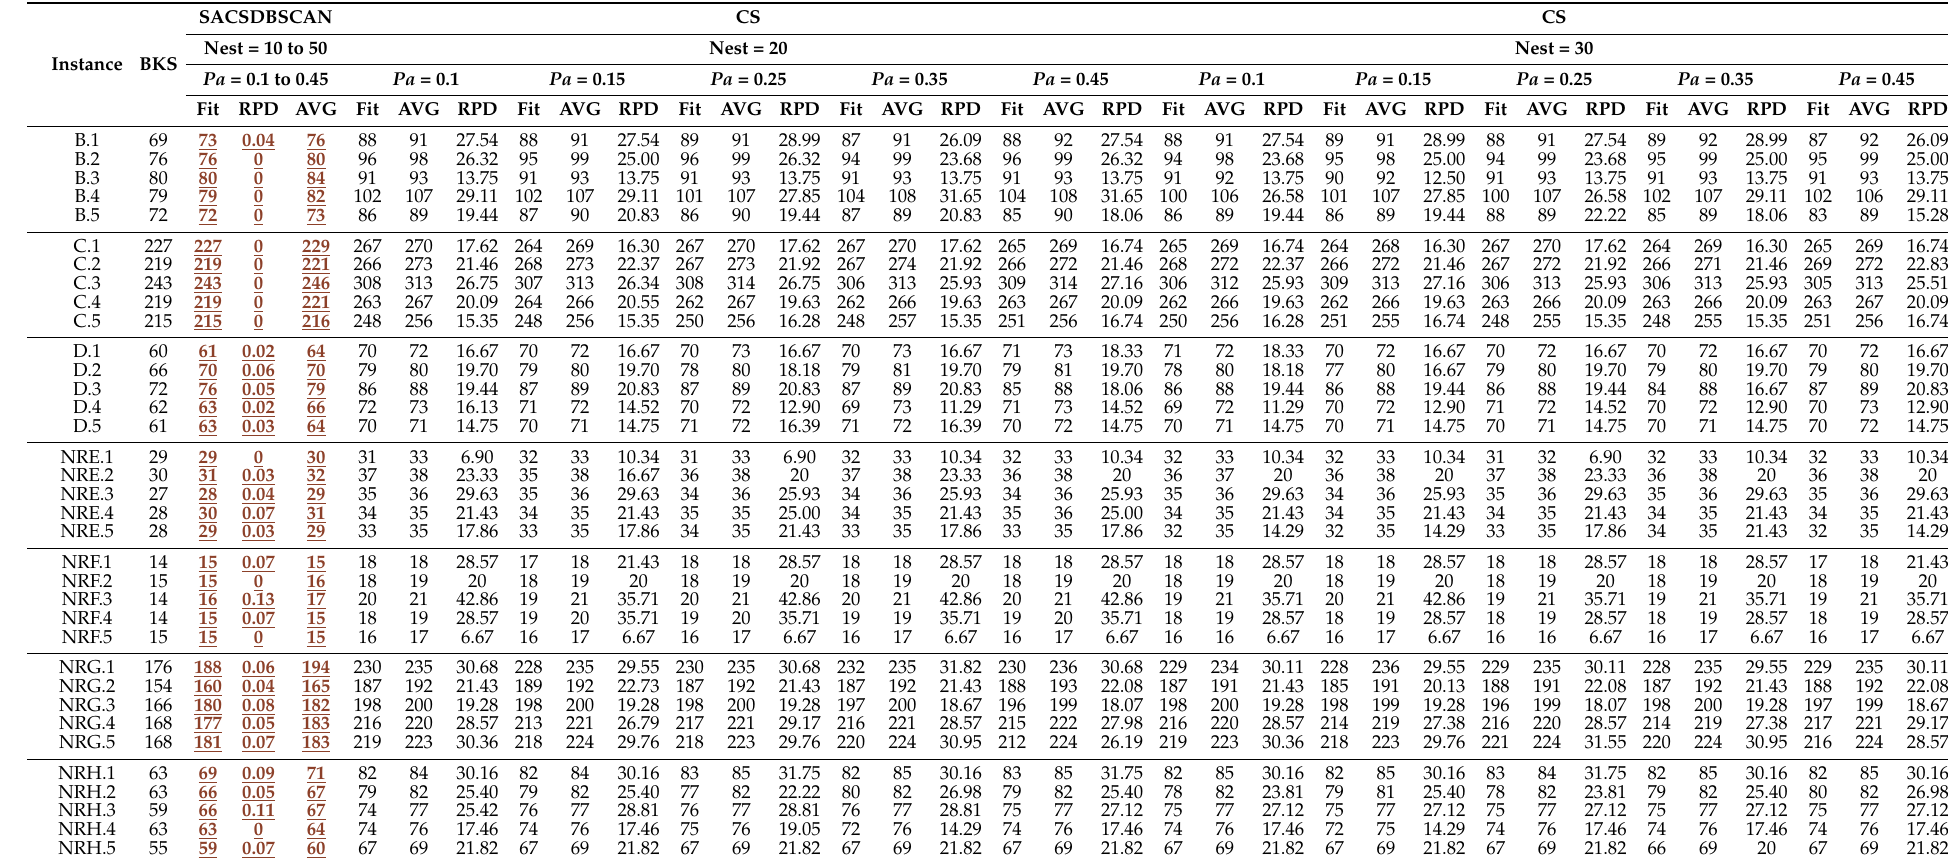
Table 6. Comparison results for set of groups B, C, D, NRE, NRF, NRG, NRH. SACSDBSCAN v/s CS Nest = 20,